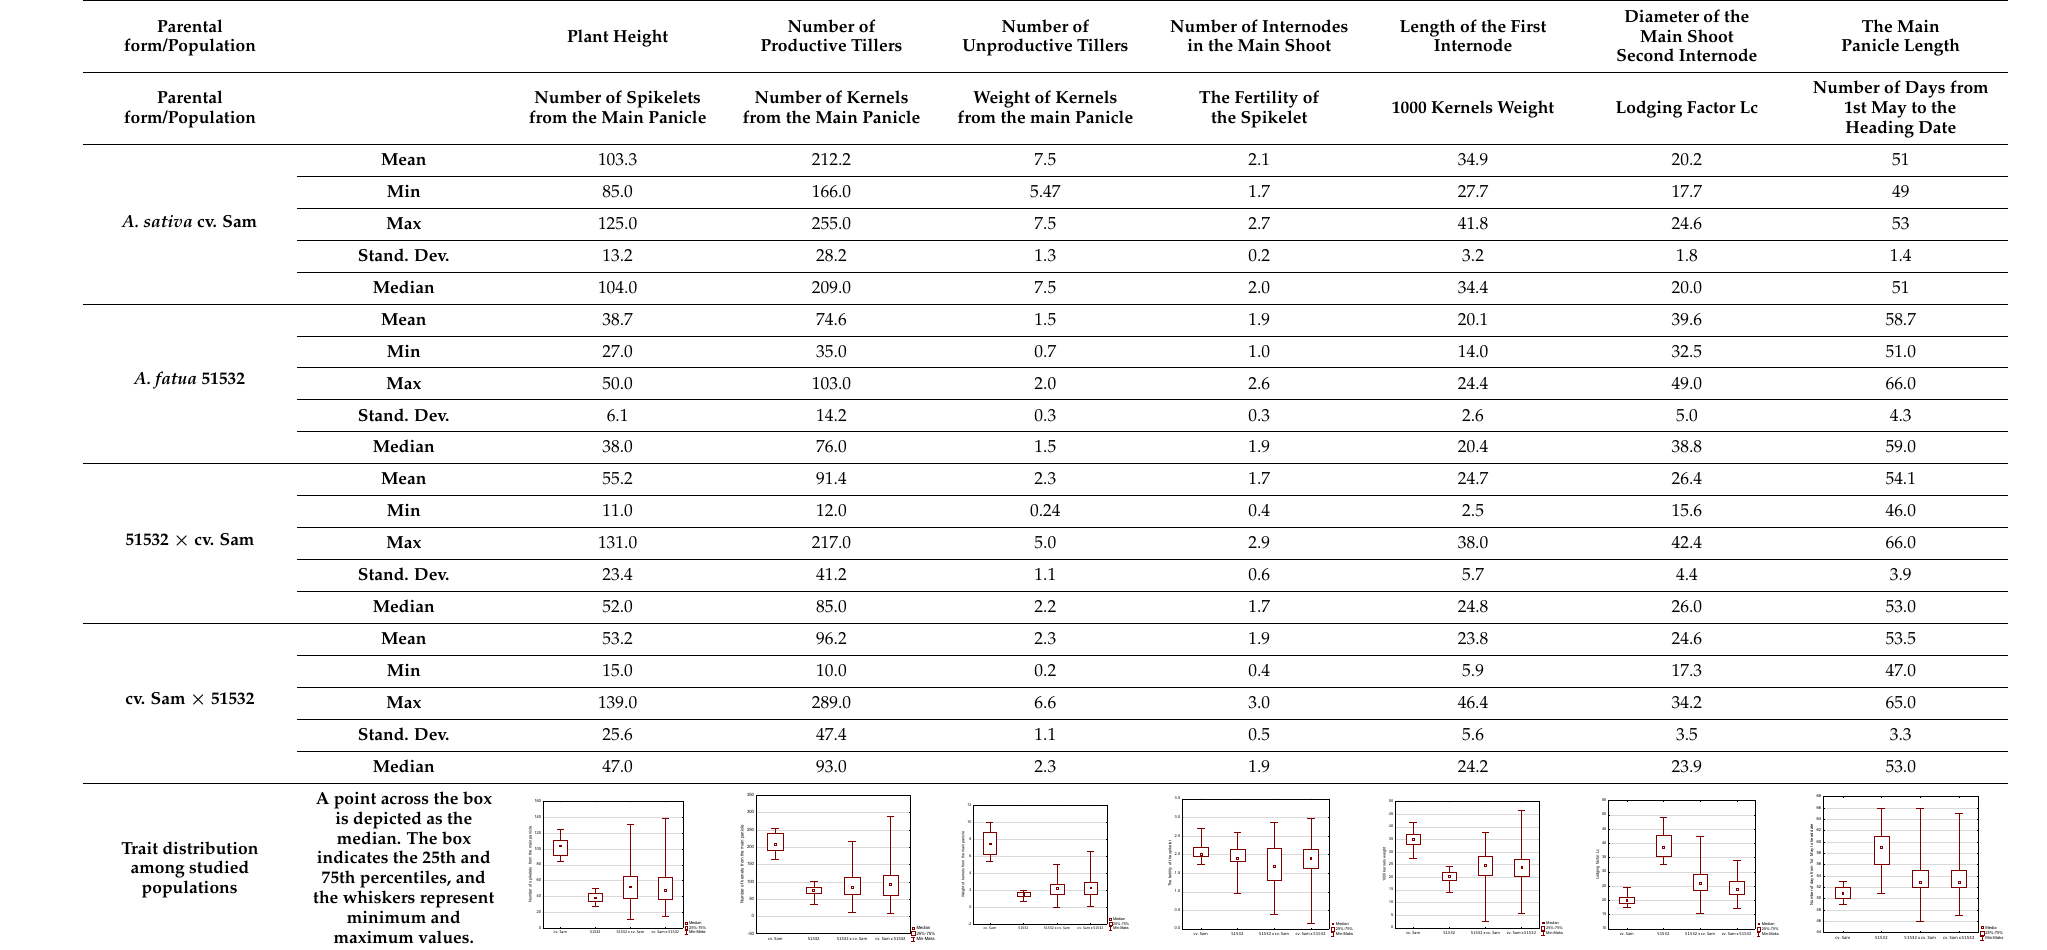
Table 2. Mean ranks post hoc comparison of agronomic traits among parental forms Avena sativa cv. Sam and Avena fatua ‘51532’ as well as their F 2 populations. Lowercase letters (a, b, c, d) indicate homogeneous groups ( p < 0.05).